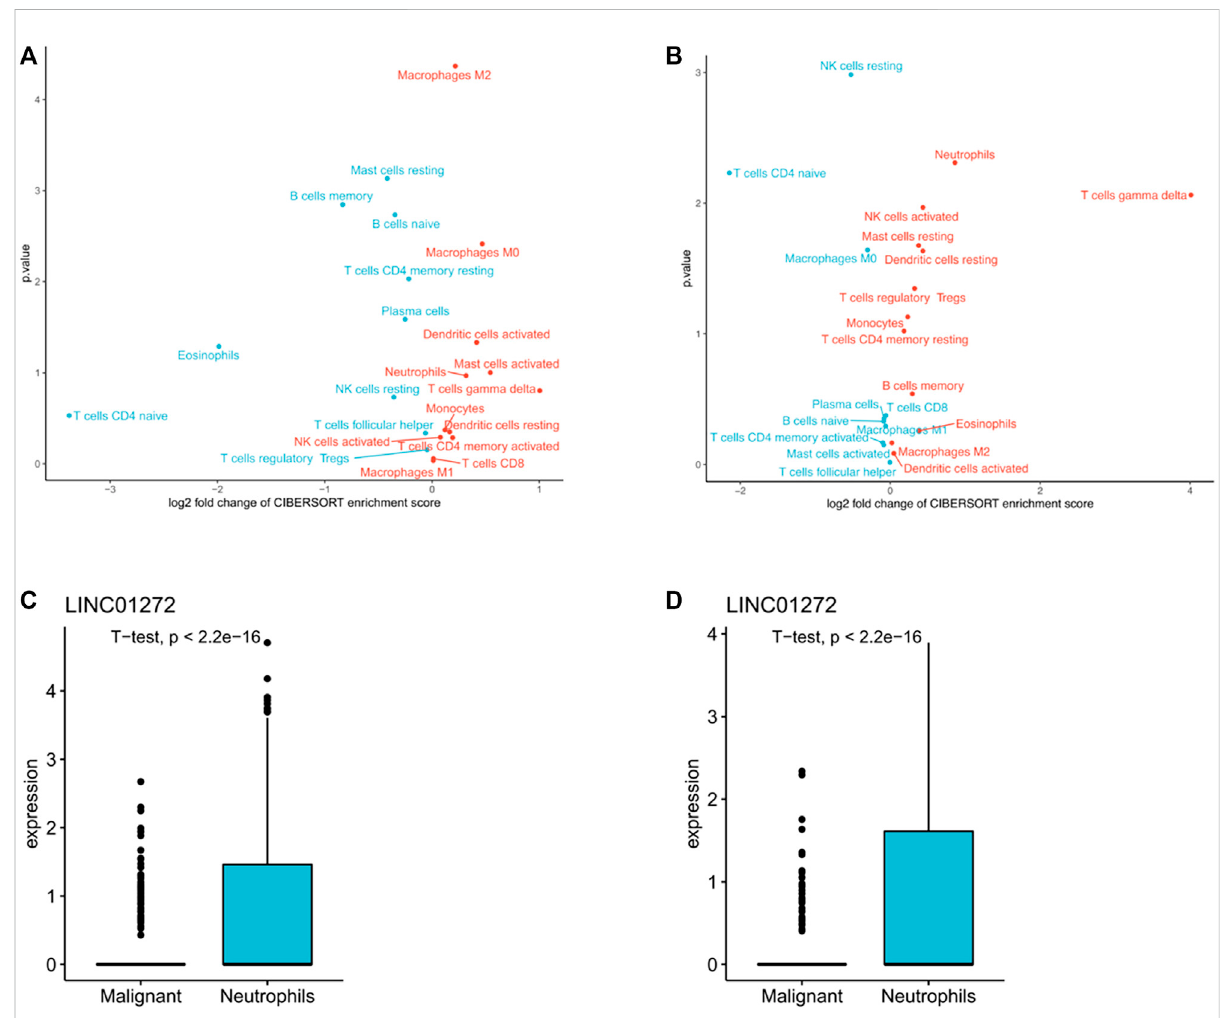
FIGURE 7 (A,B) An analysis of tumors with high and low TANlncSig based on the NES score from the GSEA in LUSC and LUAD provided the volcano plots for the enrichment of immune cell subpopulations. (C,D) The boxplots show lncRNA expression in both LUSC and LUAD neutrophil cell